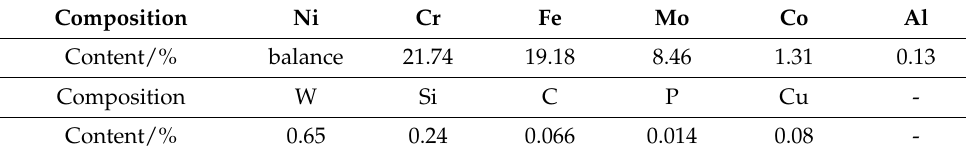
Table 2. The compositions of Hastelloy X alloy (wt.%).